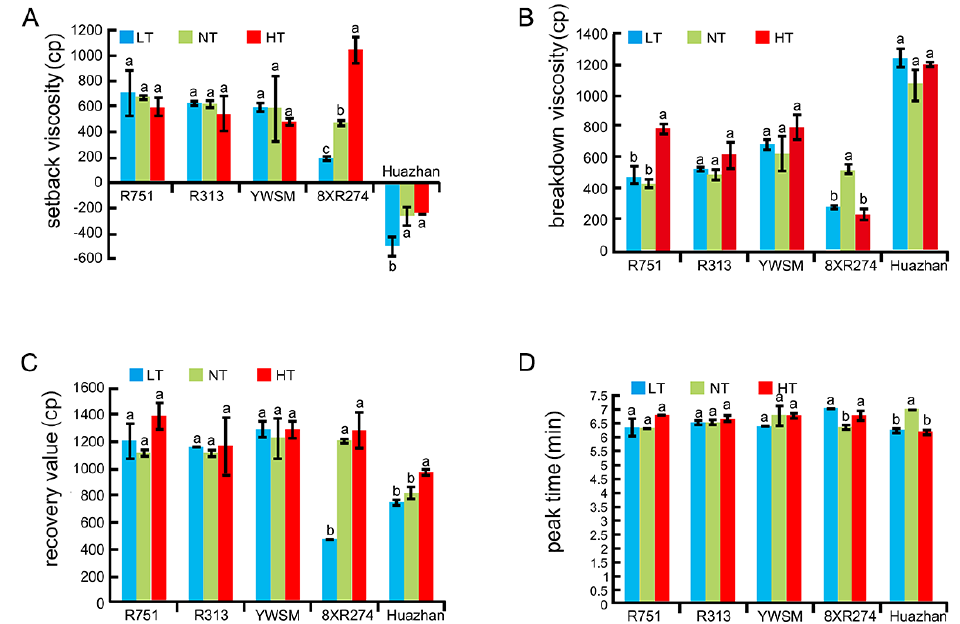
Figure 5. Starch pasting properties as determined by RVA analyses. ( A ) Setback viscosity. ( B ) Breakdown viscosity. ( C ) Recovery value. ( D ) Peak times of the five restorer lines experiencing HT (high temperature), NT (normal temperature), and LT (low temperature) during the grain-filling stage. The unit of starch viscosity is cp, 1 cp = 1/12 RVU (rapid viscosity units). Data are shown as mean ± standard error of triplicate measurements. Different letters are added above standard deviation to express significant differences ( p < 0.05).